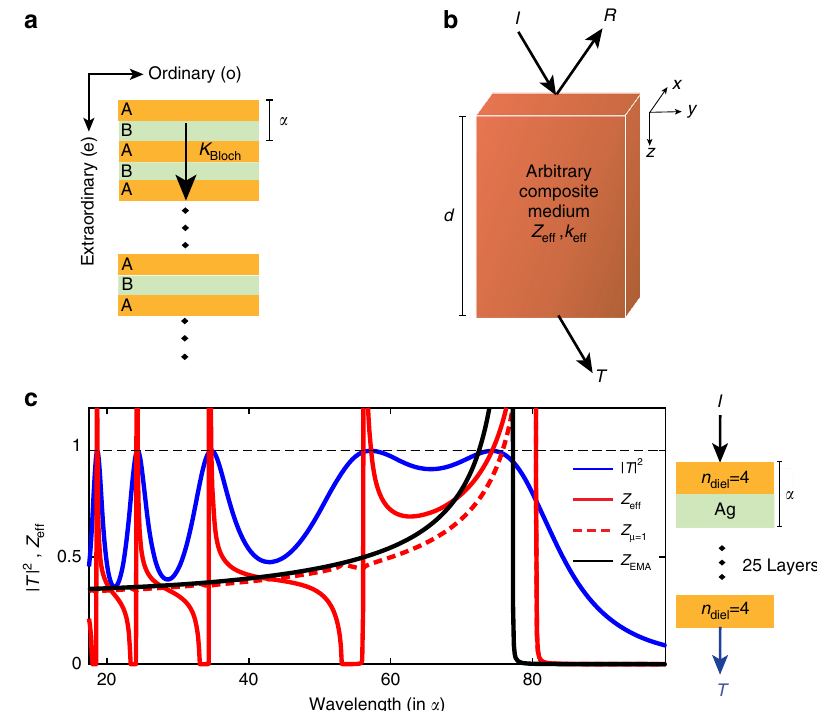
Fig. 6 Comparison between effective medium theory (EMA) and Bloch approaches and S-parameter retrieval. a EMA and Bloch formalisms (for in fi nite periodic arrangements), α is the lattice period and K Bloch is the Bloch wavenumber, b general concept of S-parameter retrievals that take fi nite total thickness d into account. T and R are the transmitted and re fl ected amplitudes and Z eff and k eff are the effective impedance and wavenumber. c Impedance- matching sanity check at normal incidence for a twenty- fi ve layers dielectric/metal metamaterial, for n diel = 4. The transmittance T j j 2 calculation (blue solid line) was performed with the transfer-matrix formalism 55 for the physical multilayer system in the lossless limit. The dielectric and magnetic effective p(cid:7) (cid:8) ffiffiffiffiffiffiffiffiffiffiffi μ = ϵ (red solid line) accurately captures the resonances unlike the non-magnetic approach Z μ model Z eff ¼ o o Garnett EMA (black solid